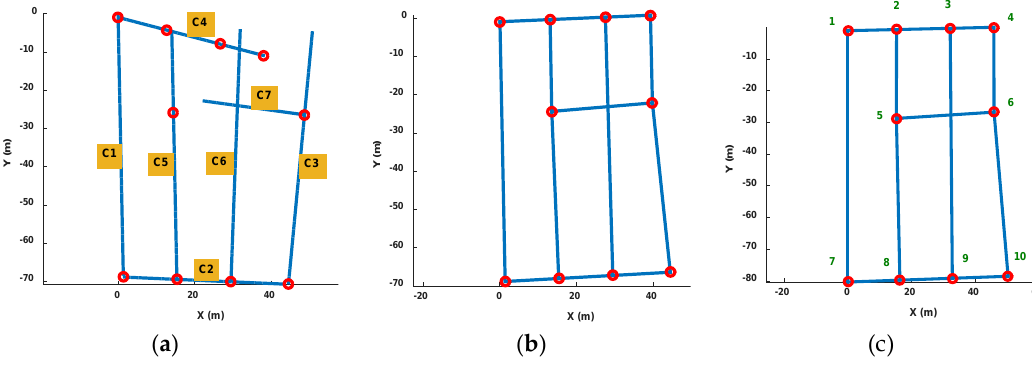
Figure 20. Topology map construction results: ( a ) rough result after road length and connection estimations; ( b ) pathway map after topology modification; ( c ) final pathway map after orientation correction.